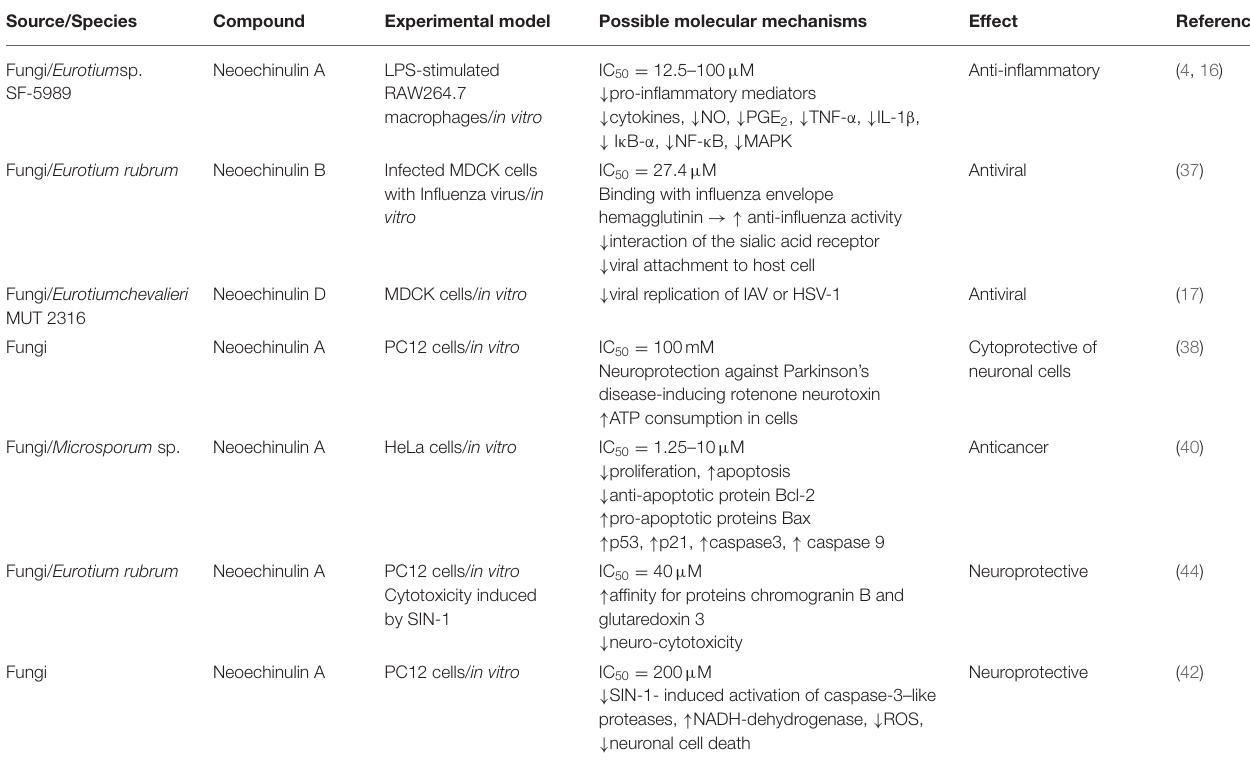
TABLE 2 | The most relevant pharmacological properties of neoechinulins, possible mechanisms, and signalling